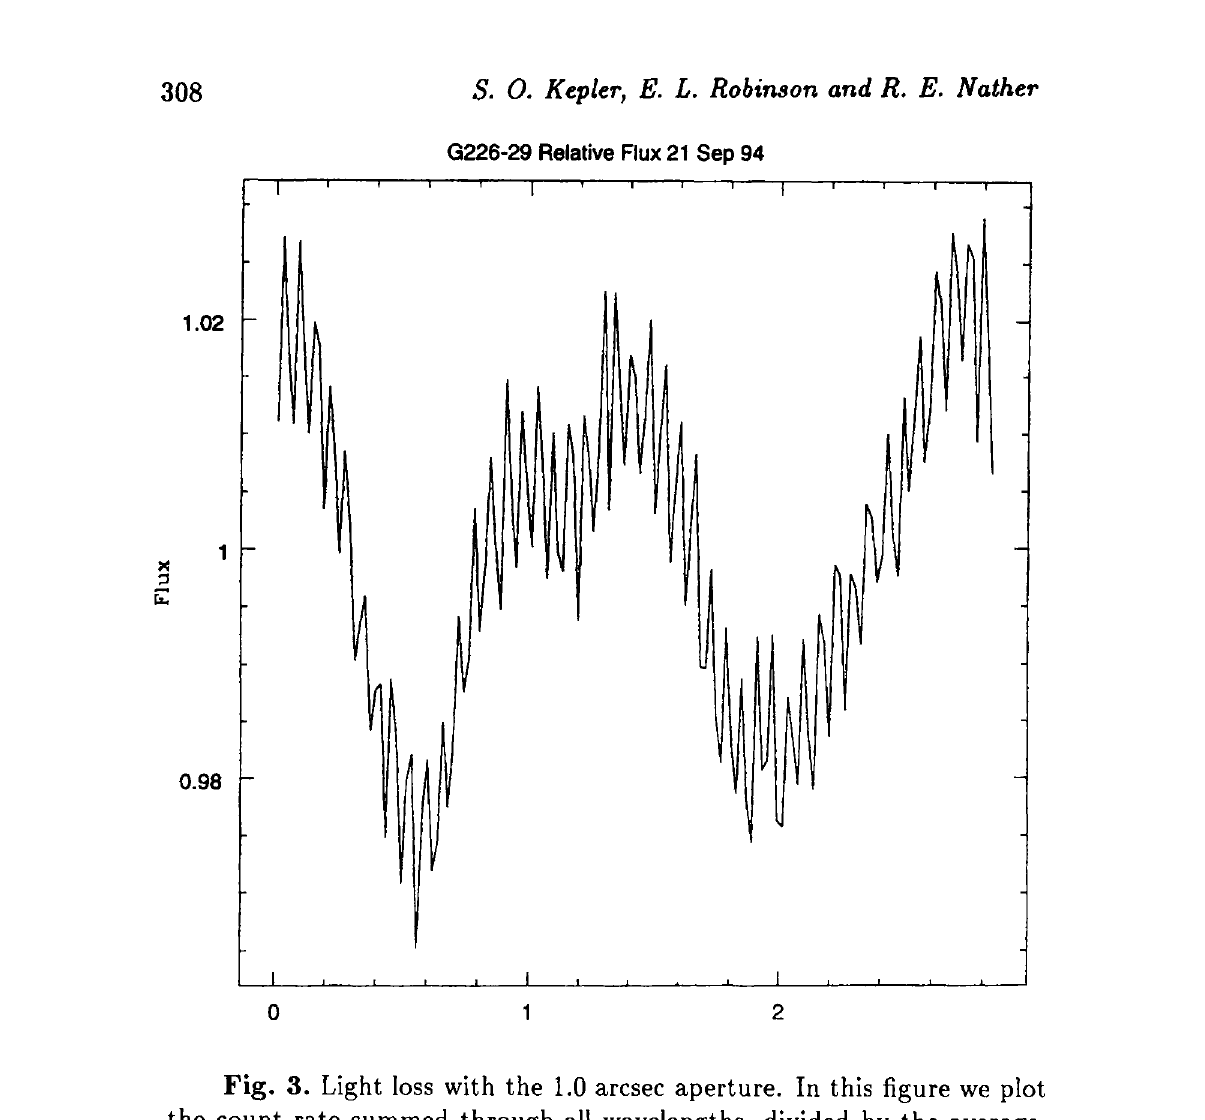
Fig. 3. Light loss with the 1.0 arcsec aperture. In this figure we plot the count rate summed through all wavelengths, divided by the average, versus time. The rapid variation on a time scale of 100 s is caused by the pulsations of the